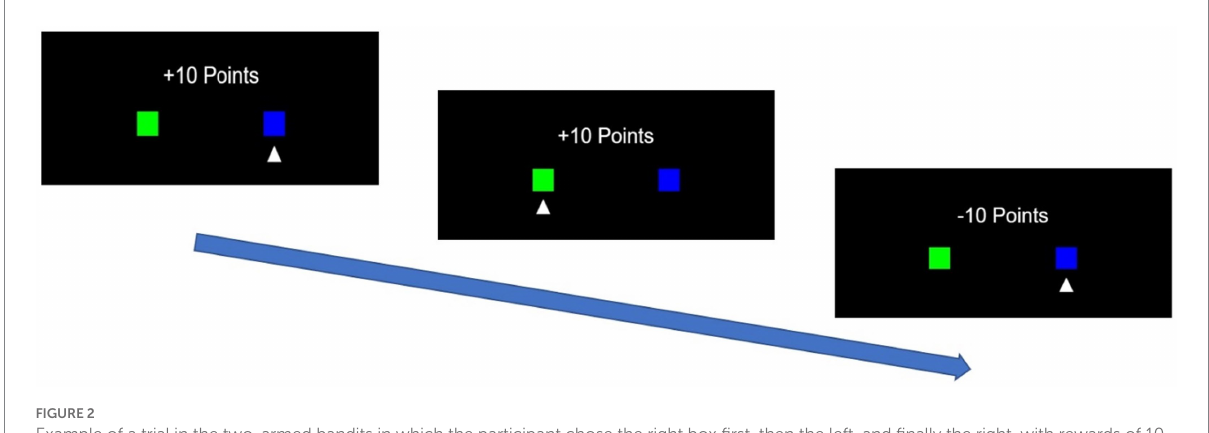
FIGURE 2 Example of a trial in the two-armed bandits in which the participant chose the right box first, then the left, and finally the right, with rewards of 10 points, 10 points, and − 10 points,